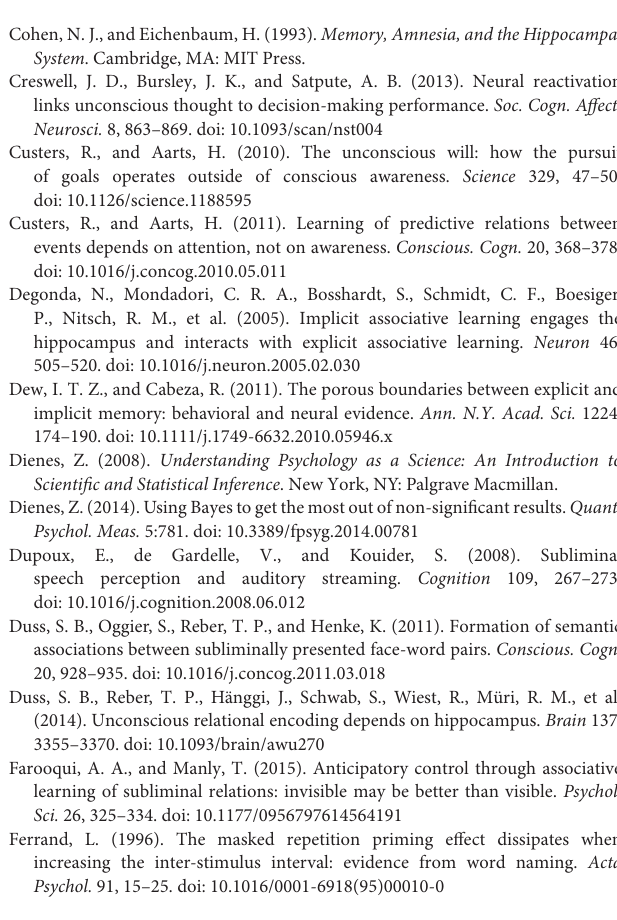
Supplementary Table 1 | List of all occupation words used in the current study. Word-frequency obtained from the Leipzig Corpora Collection (http://corpora.uni- leipzig.de/), word length (number of letters), and mean estimated income as rated by an independent sample of 34 participants are indicated. Words are grouped by stimulus lists (A, A ′ , B, and B ′ ) that were used to counterbalance stimuli across conditions, and by wage-category. Pairs of semantically congruous occupation words are labeled with the same identification number. Supplementary Table 2 | List of all consonant strings with corresponding word lengths (number of